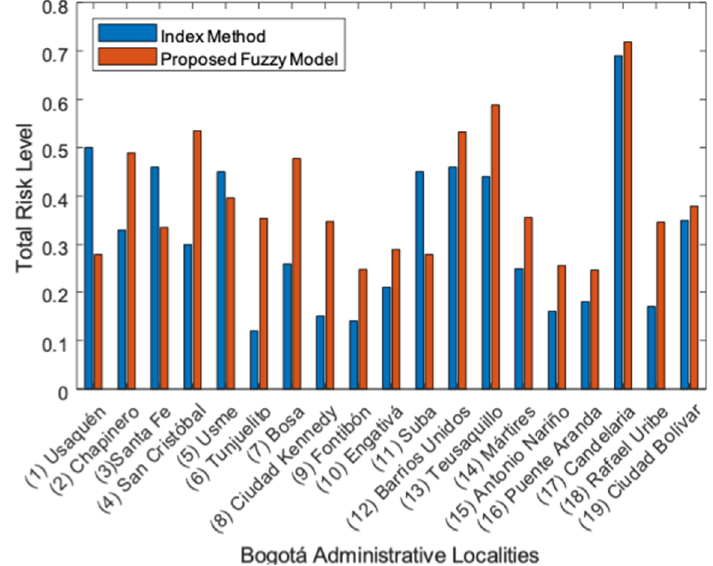
Figure 10. Physical Risk values obtained for the 19 administrative localities of Bogotá with the index method and the proposed fuzzy model.